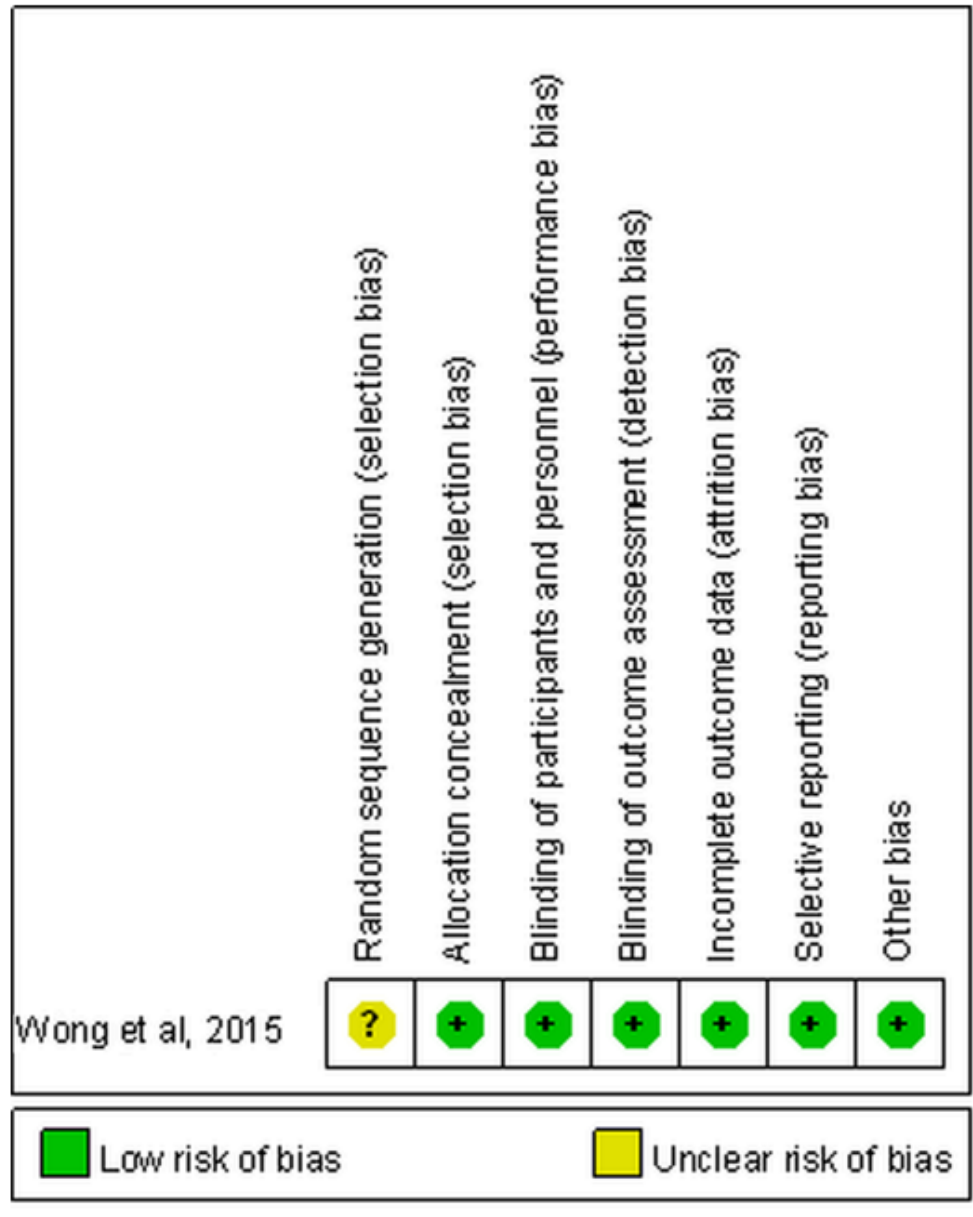
Figure 2. Summary for risk of bias of randomized controlled trial.